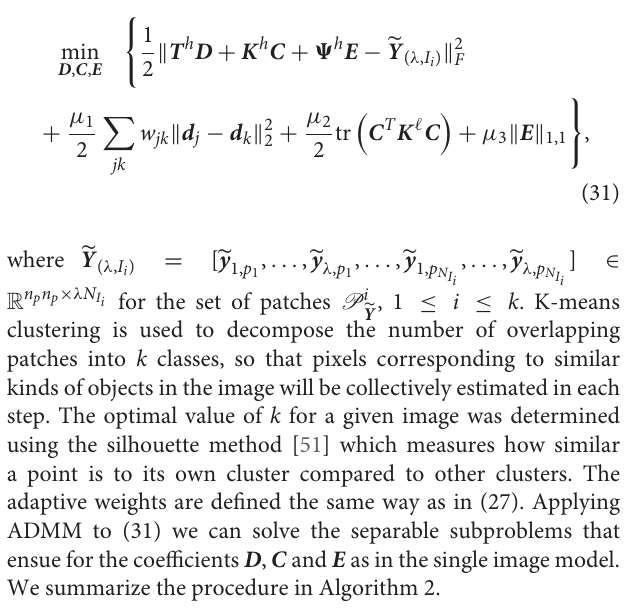
Algorithm 1: Analog three-dimensional single image SR